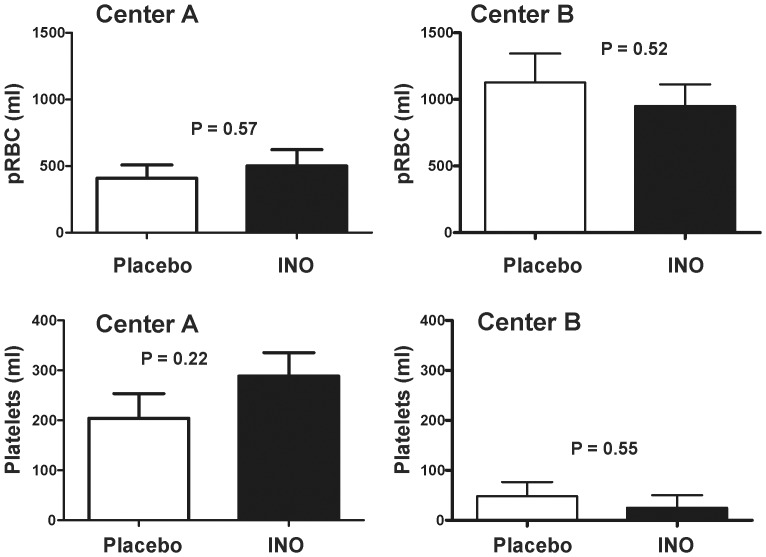
iNO therapy did not affect volume of packed RBC (pRBC) or platelets transfused during liver transplant surgery at either study site.Data are mean ± SEM (n = 20 for each group, except UAB placebo where n = 19). Indicated p-values calculated by unpaired t-test.